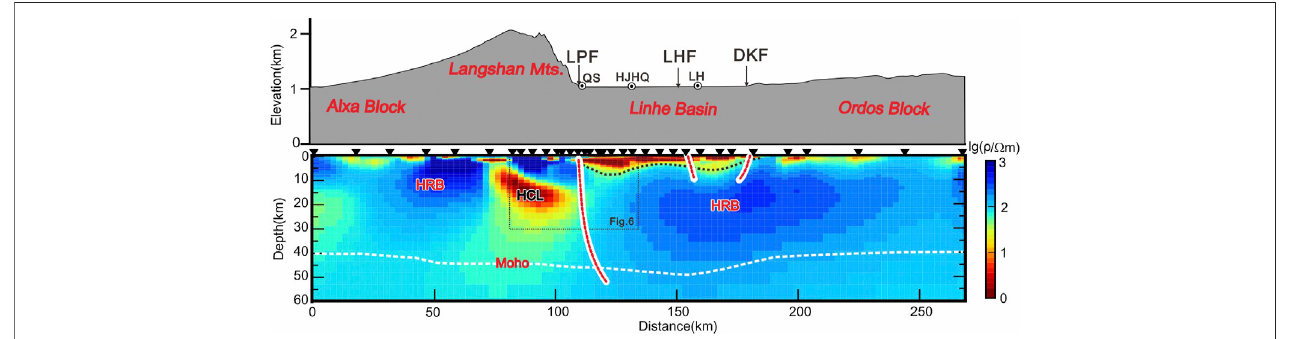
FIGURE5| Deepelectricalstructure mapobtainedusingthree-dimensionalinversion andthetopographicaldistributionmapofthepro fi le.Thereddottedlinesare thedeepdistributionofthefaultinferredfromthemagnetotelluric(MT)results,andtheblackdottedlineisthebottomboundaryoftheCenozoicsedimentarylayerinferred from the MT results. The white dotted line is distributed along the Moho surface (Chen et al., 2020).